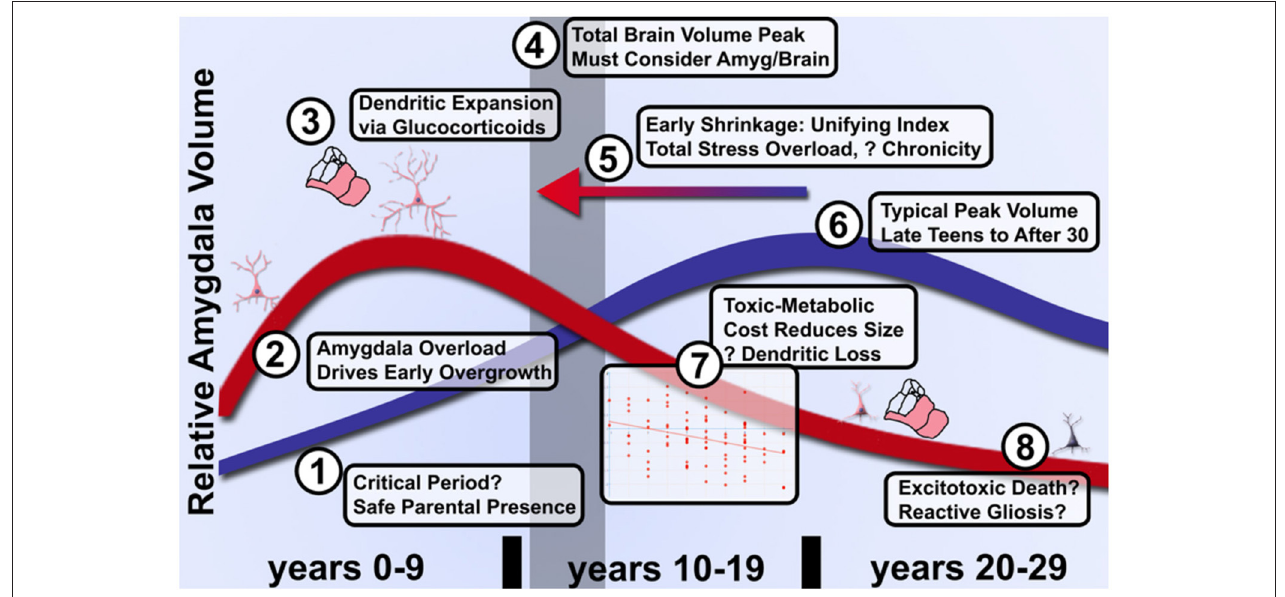
FIGURE 3 | Model of graded acceleration of amygdala volume relative to brain volume and regions of clarification needed in future studies of allostatic load in ELA. (1) It has not been established whether a critical period exists during the first several months of parental attachment or after during which parental presence facilitates overcoming adversity and an enduring sense of parent-cued safety. (2) As noted above, more evidence will be needed to clarify whether early enlargement or rate of growth is quantitatively linked to degree of subjective adversity. (3) While certainly involving glucocorticoids, dendritic expansion and a shift toward excitation over inhibition, the limits on peak volume and transition to shrinkage is poorly understood even in ASD. (4) These changes relative to control volumes must be further couched in an understanding of typical brain development that likely peaks by the preteen years, thus even a shift earlier in life (5) of the same curve could manifest as a distinct quadratic shape in proportion to severity of adversity. (6) Furthermore, the peak of typical amygdala development and influences on timing have not been fully elucidated due to the challenges of longitudinal study. (7) Provided individuals are assessed after the quadratic peak, amygdala shrinkage quantitatively reflects cumulative life adversity and better characterization of this pathophysiology may distinguish effective treatments from the natural course of disease. (8) Whether inflammation in the form of reactive gliosis and excitotoxic death occur and can be prevented will require better longitudinal tools that track microsctructure and neurochemistry